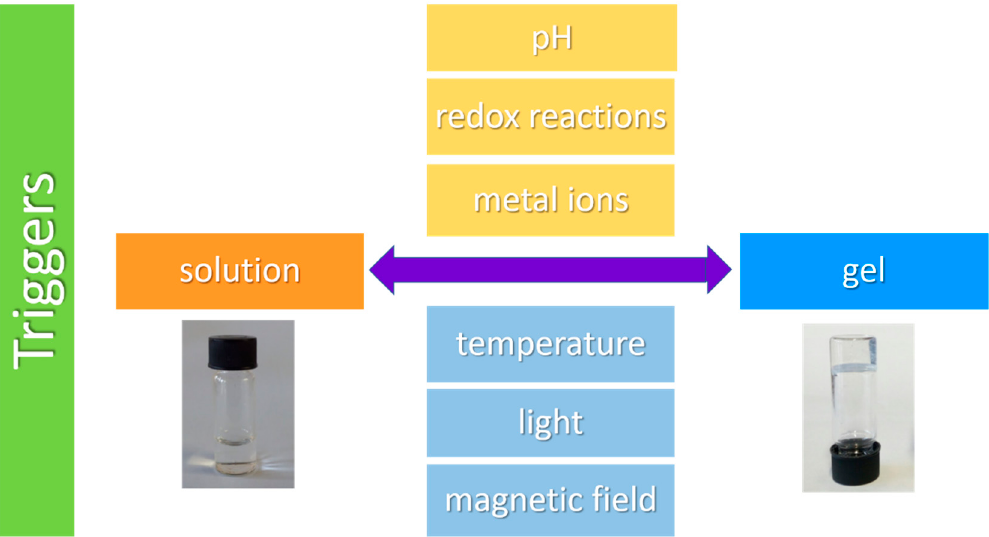
Figure 3. Common triggers for peptide self-assembly and disassembly. Gelation triggers shown in yellow involve a chemical input, whereas gelation triggers shown in light blue do not require a chemical input (i.e., can be manipulated remotely).